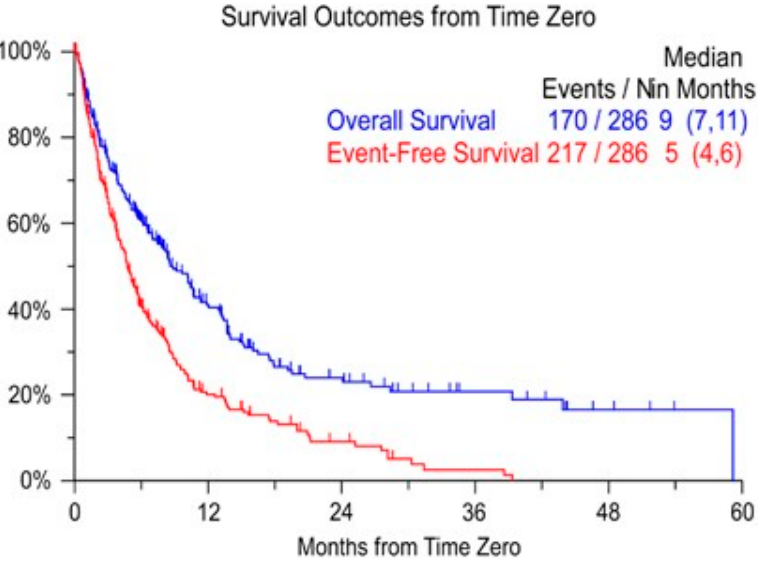
Figure 1. Survival after being refractory to bortezomib and relapsed/refractory or intolerant to an IMID [5].